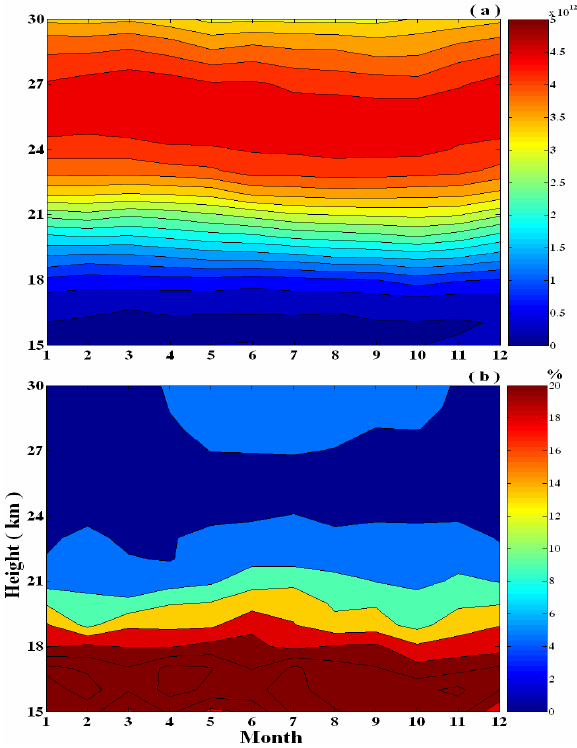
Fig. 5. Same as Fig. 4 but for the HALOE satellite FIGURE – 5: same as figure -4 but for the HALOE satellite data